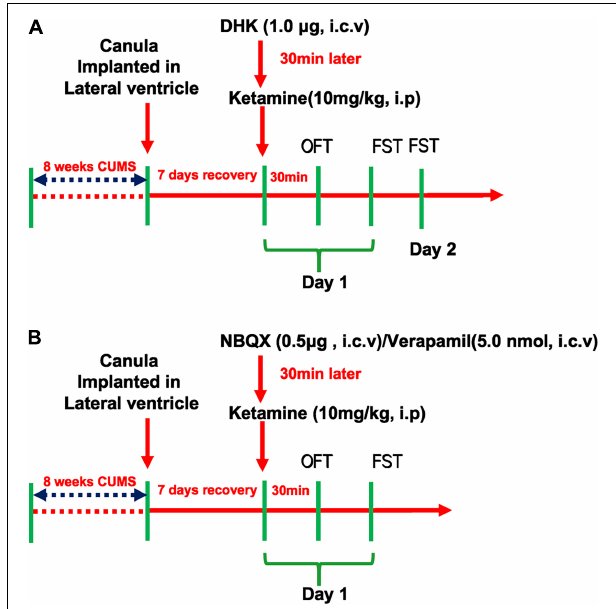
FIGURE 1 | Schedule of drug treatment and behavioral tasks orders. The experiment design of GLT1 inhibition in the rapid antidepressant-like effect of Ketamine (A) and the involvement of AMPAR/L-VDCC in the regulation of Ketamine on GLT1 (B)